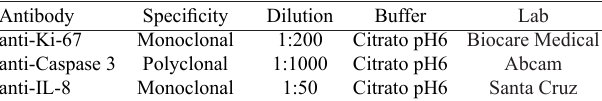
Table 2. List of antibodies